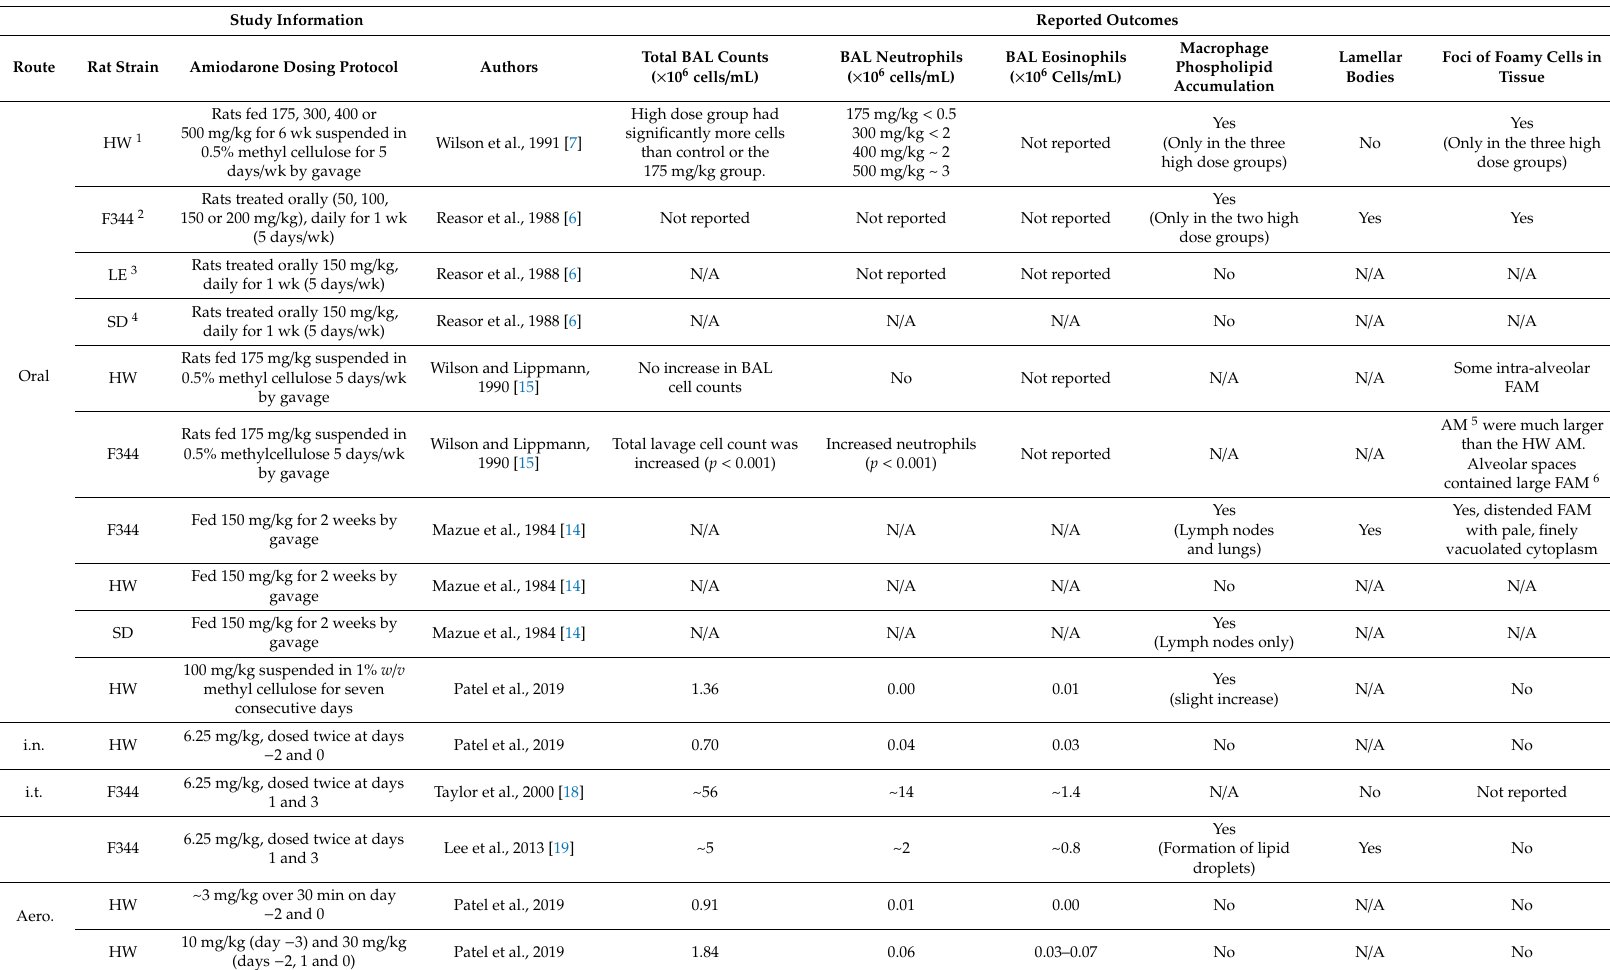
Table 2. Overview of the characteristics of amiodarone induced phospholipidosis